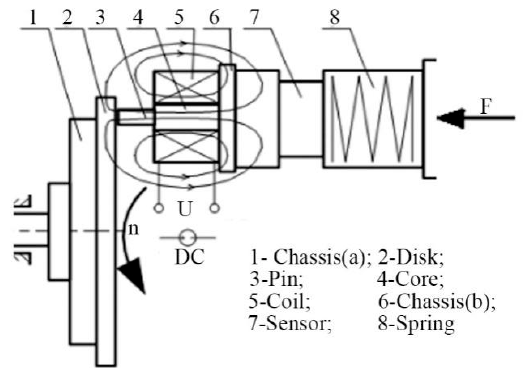
Figure 1 Schematic diagram of the tribometer. Figure 1. Schematic diagram of the